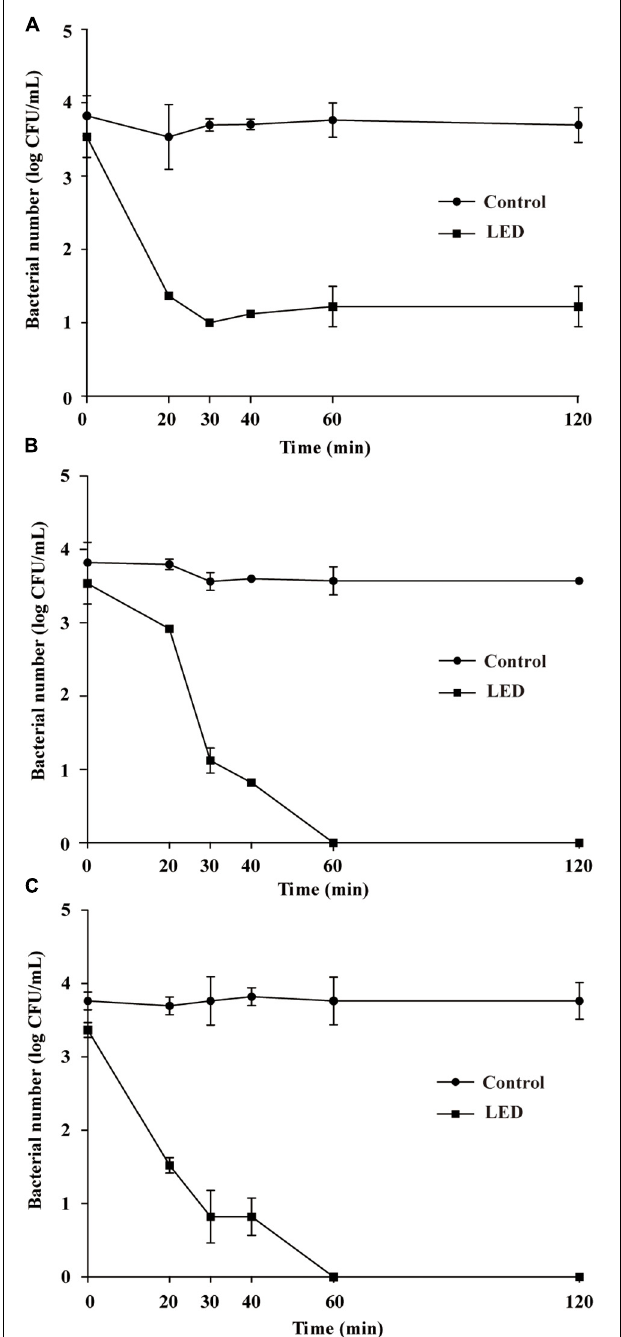
FIGURE 3 | Survival of LED-illuminated and unilluminated L. monocytogenes in 10% (w/v) NaCl (A) , 15% (w/v) NaCl (B) , and 20% (w/v) NaCl (C) .